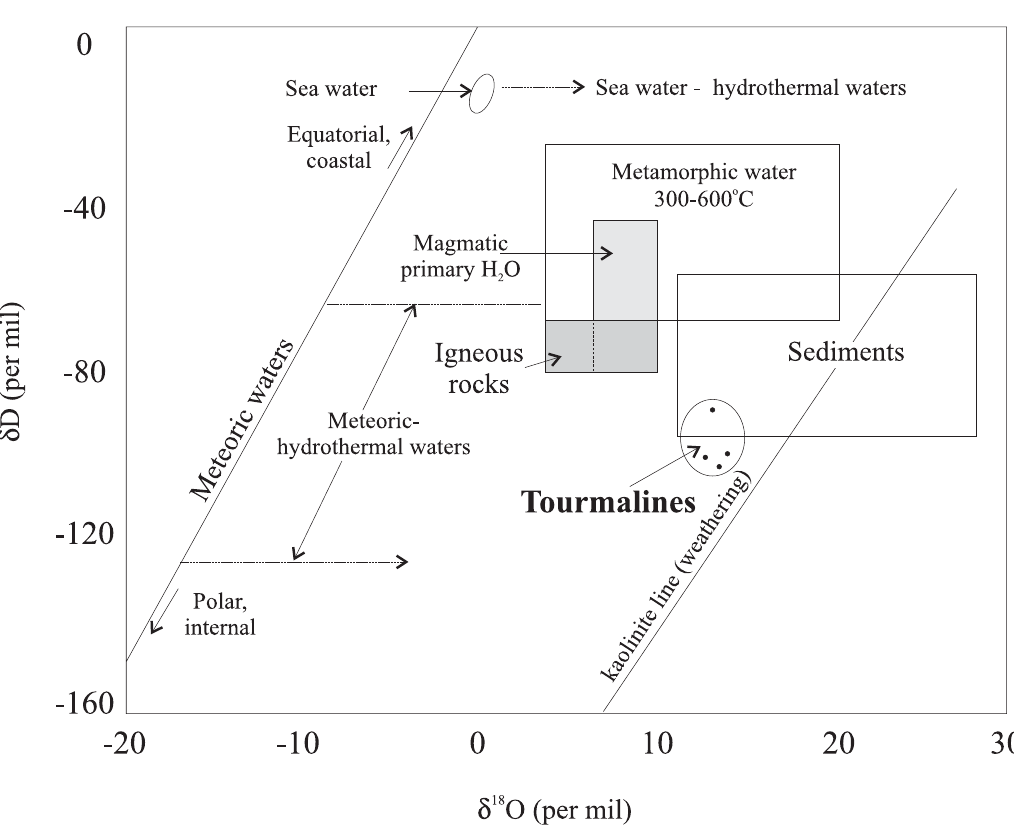
Fig. 8 – Representation of δ 18 O and δ D values obtained for tourmalines from Tapera Grande and Quartzito in Taylor’s (1967) diagram for isotopic compositions of waters from several